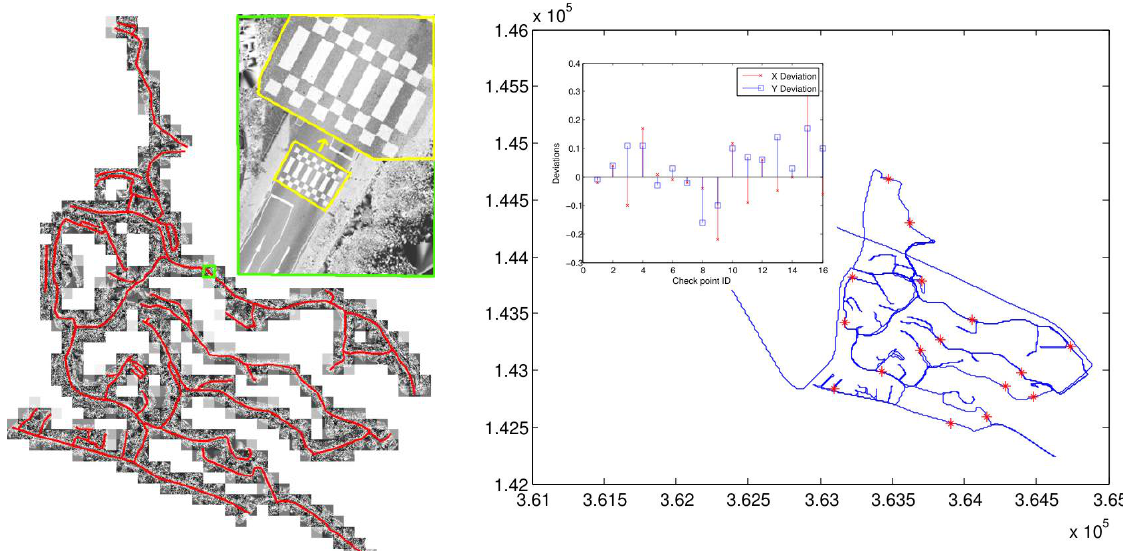
Figure 4: Left: Overview of NUS campus point cloud intensity data. Right: Distribution of check points and their coordinate differences at X and Y directions (Unit: